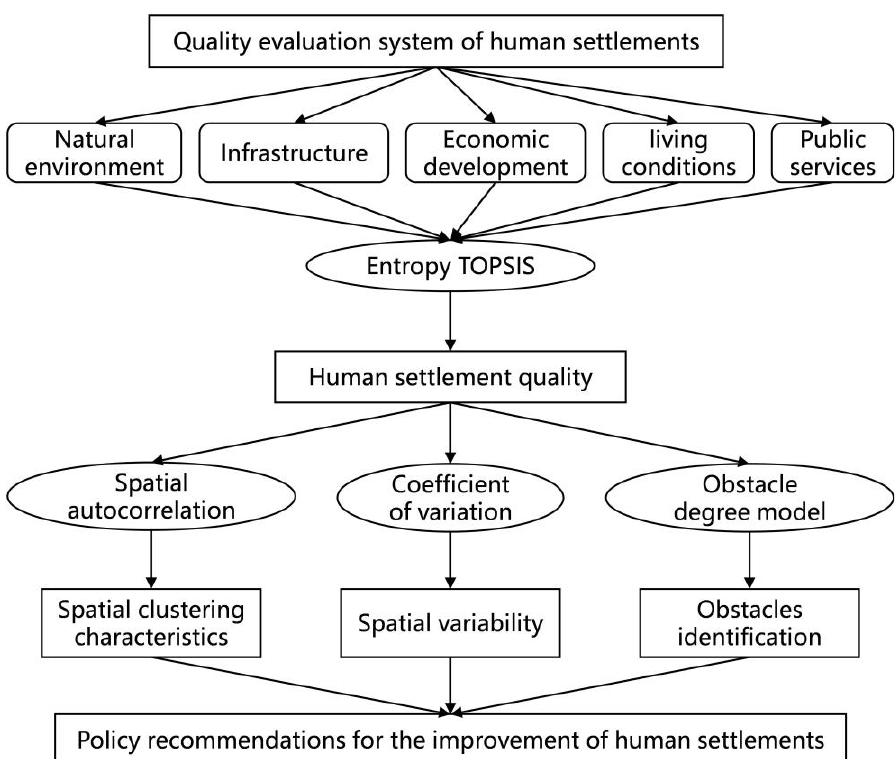
Figure 2. Research technology road map.